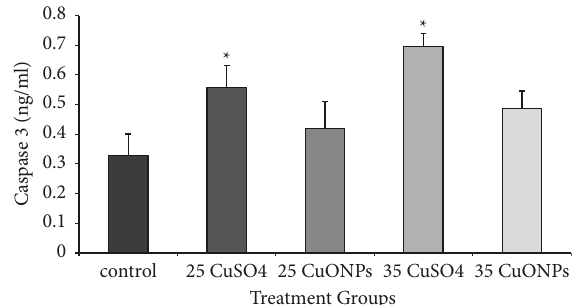
Figure 7: Caspase-3 level in rat testes homogenate affected by CuO NPs and CuSO 4 0.5 (H 2 O). Data represent the mean ± standard error (SE). ∗ Significantly different ( P ≤ 0 . 05) from the control